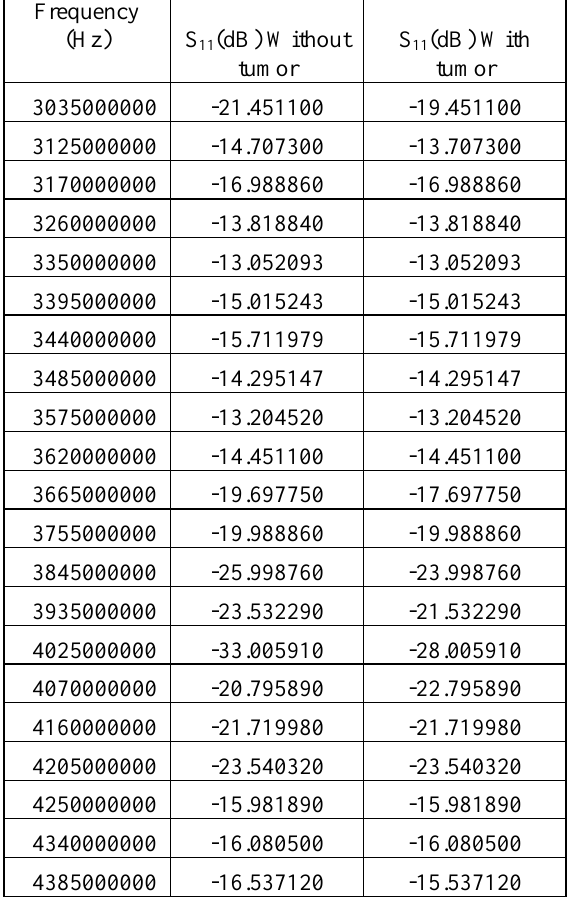
TABLE III. Frequency Domain Values of Simulation Result